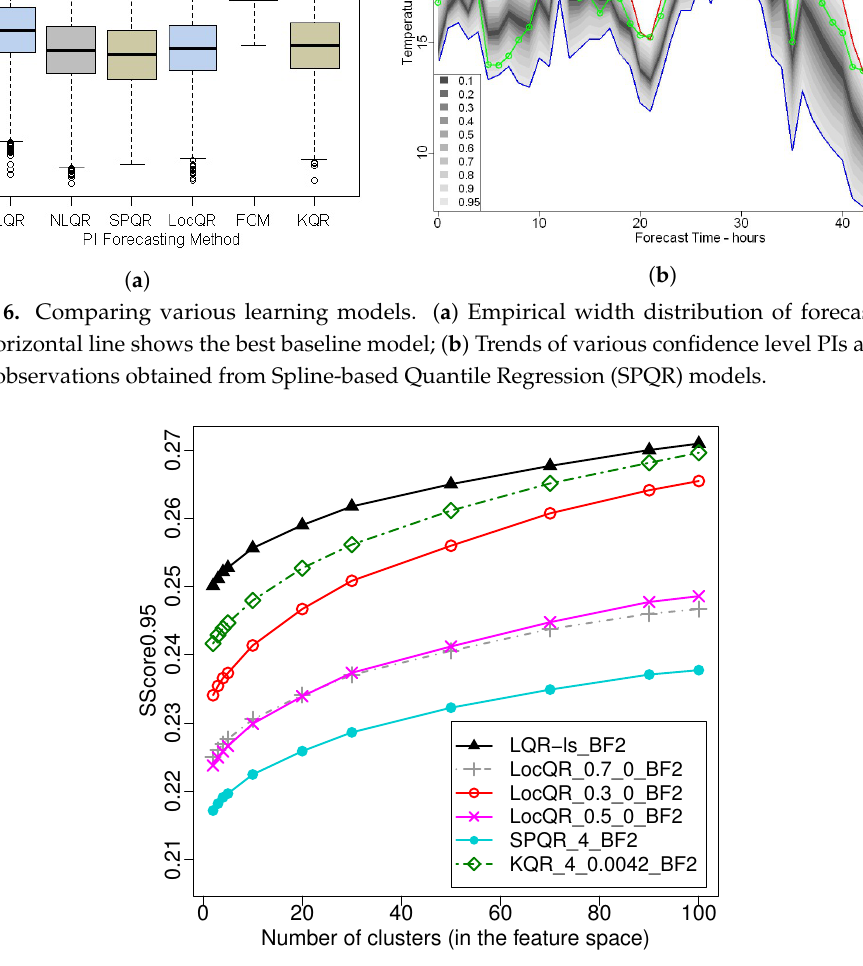
Figure 7. Trends of SScore 0.95 for the top quantile regression